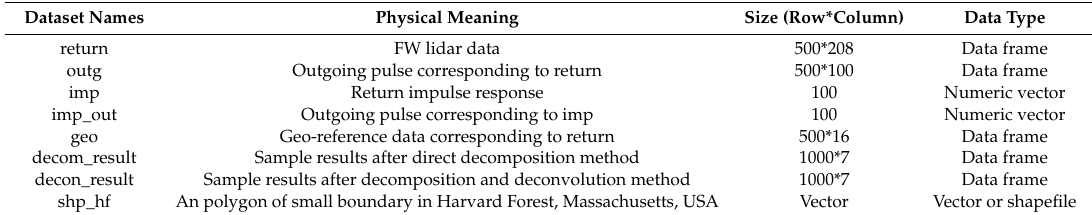
Table 1. A summary of example data sets for waveformlidar